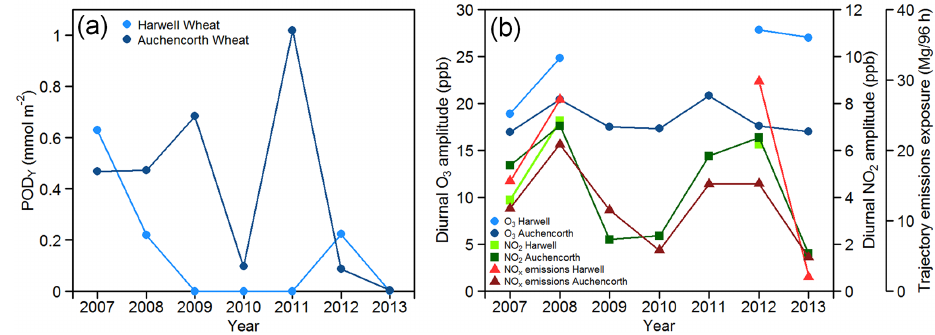
Figure 12. (a) Wheat POD Y accumulated during July at Harwell and at Auchencorth, 2007–2013. (b) Diurnal cycle amplitude of O 3 and NO 2 and back-trajectory NO x emission estimates during wheat accumulation days (ADs) in July at Harwell and at Auchencorth,